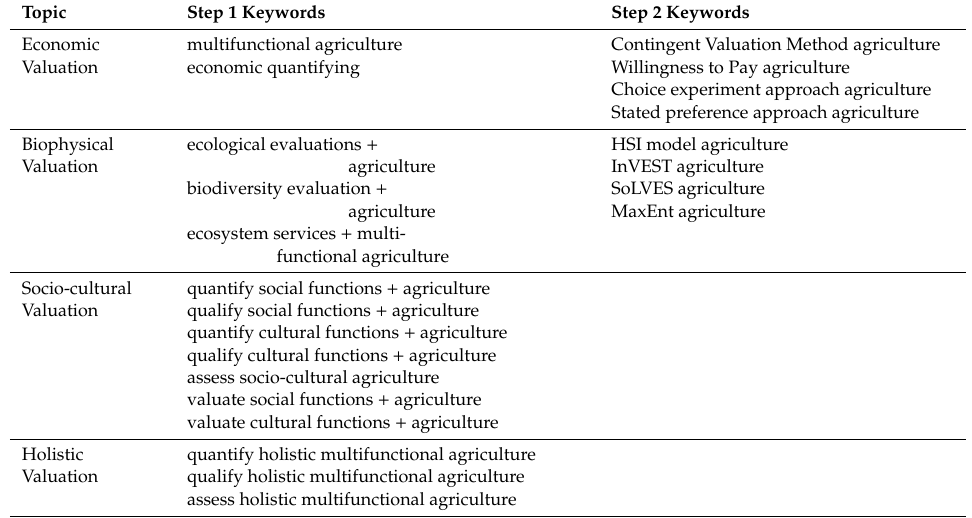
Table 1. Searches for the literature on measuring / assessing multifunctional agriculture